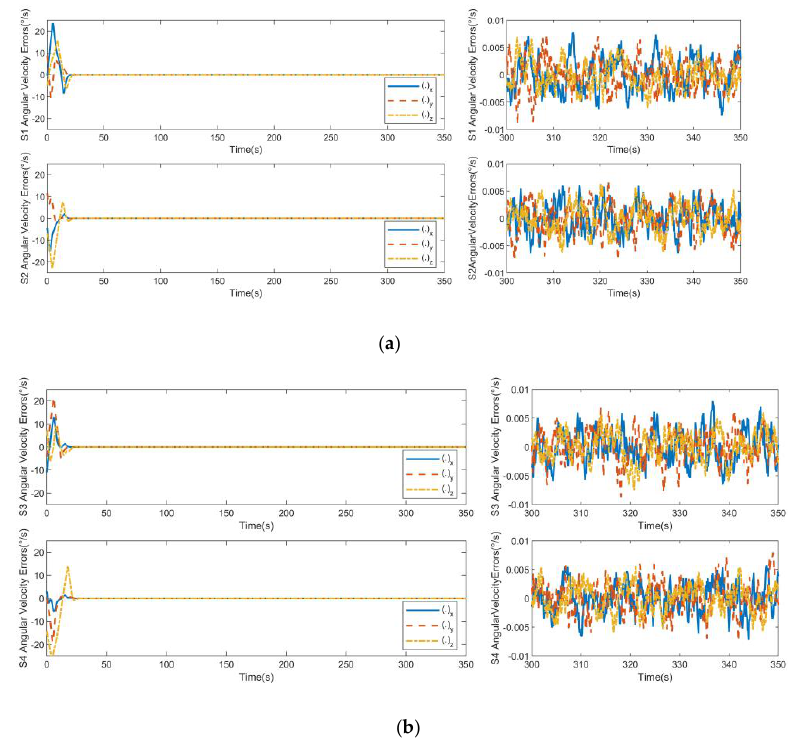
Figure 6. Angular velocity errors for non-consistent collaborative control: ( a ) S1 angular velocity errors and S2 angular velocity errors; ( b ) S3 angular velocity errors and S4 angular velocity errors.